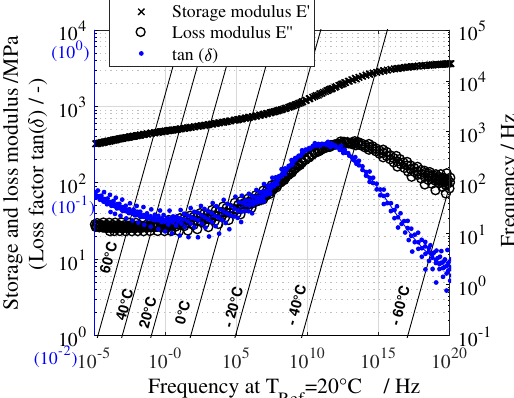
Figure 4. Master curve nomogram for tension DMA on the hard elastomer El h